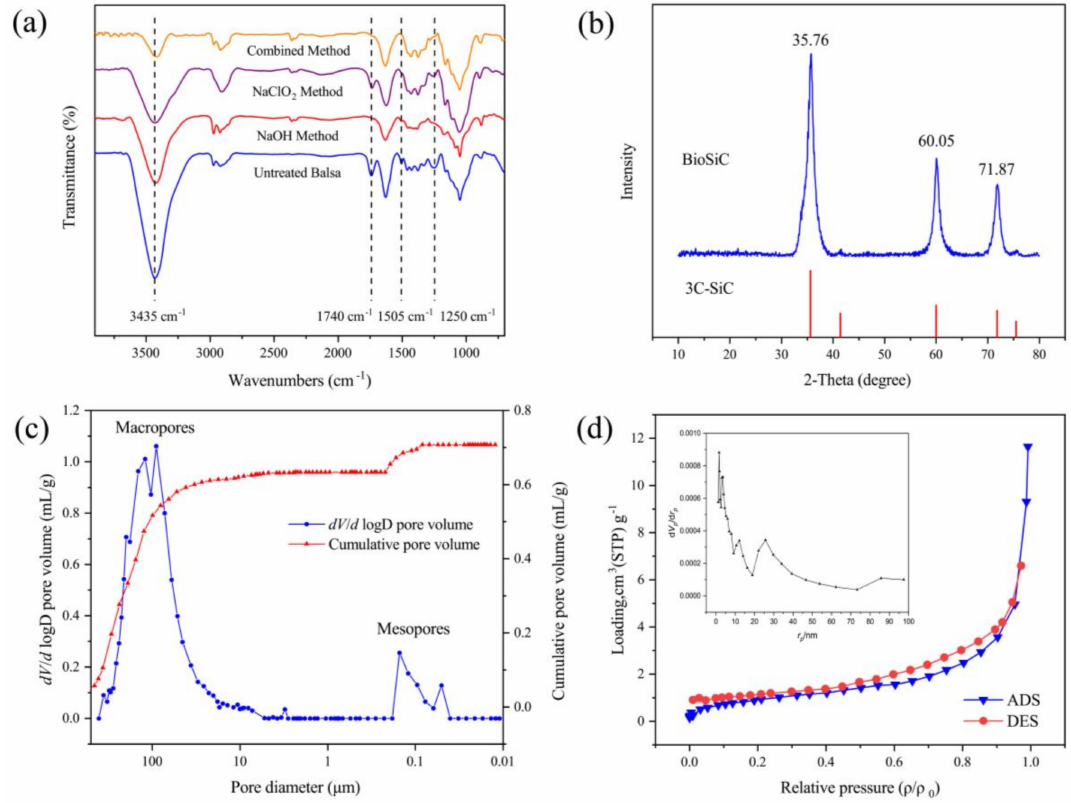
Figure 5. FT-IR spectra ( a ), XRD pattern ( b ), MIP pore size distribution ( c ), and BET&BJH plot ( d